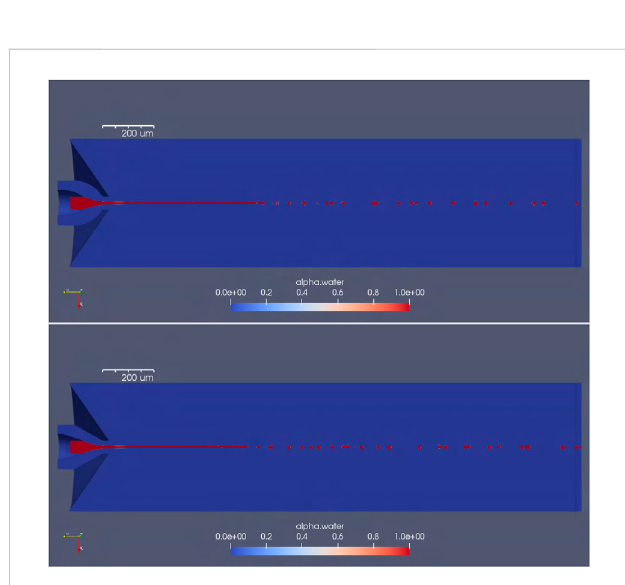
FIGURE 24 Cross section of the jet and how it breaks up into droplets for the bell-shaped design (upper picture) and the cone-shaped design (lower